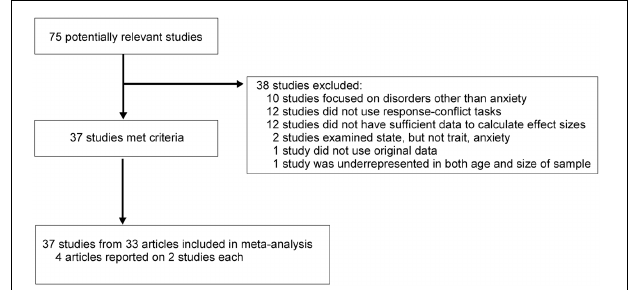
FIGURE 2 | Selection of studies. Flow chart depicting the selection of studies used in the